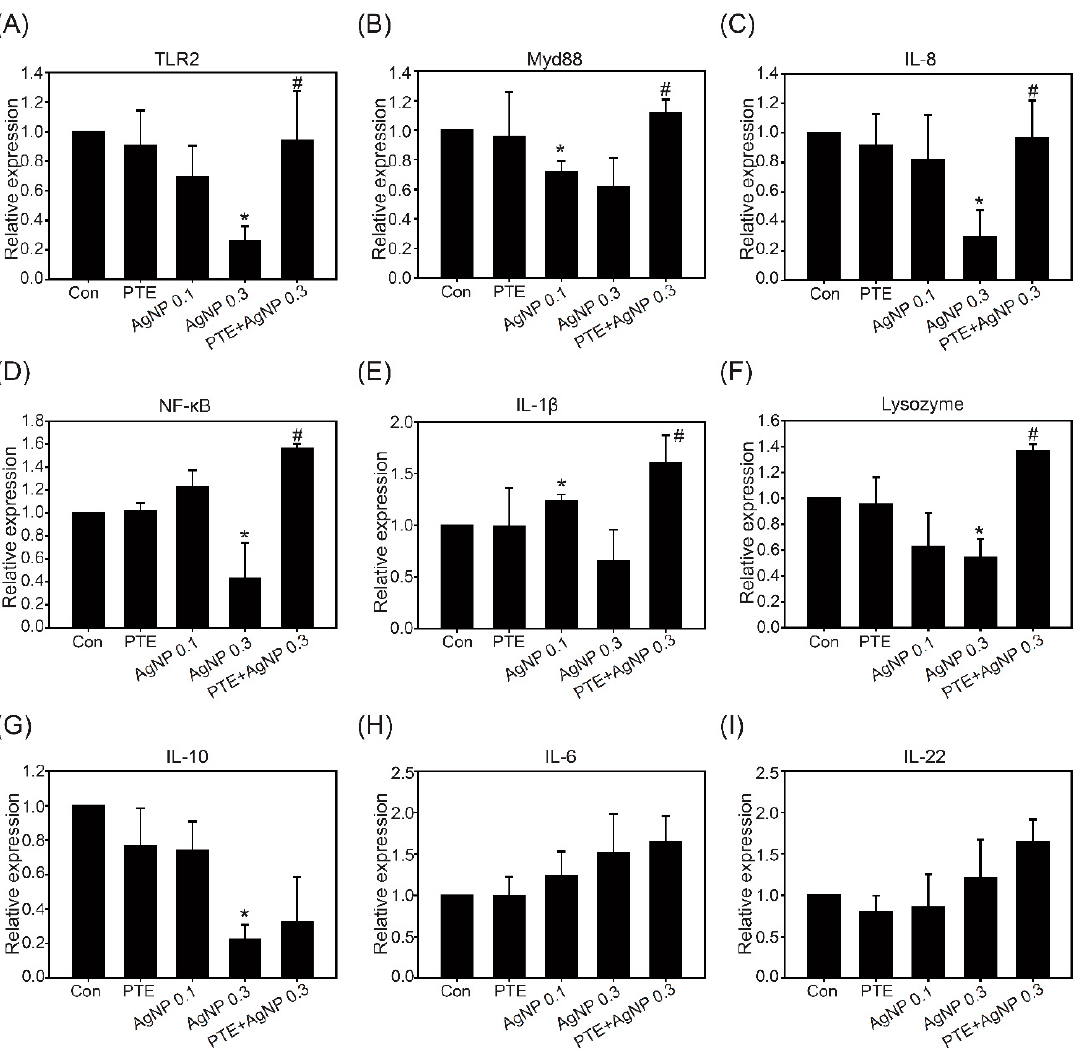
Figure 8. Expression of immune-related genes after 5 dpf exposure. Zebrafish embryos after exposure to control, 0.3 µ g/mL PLGA-PTE, 0.1 µ g/mL AgNPs, 0.3 µ g/mL AgNPs, and PLGA-PTE + AgNPs for 120 hpf. Then, the genes from whole larvae, including: ( A ) Toll-like receptors 2 ( TLR2 ), ( B ) Myd88 , ( C ) IL-8 , ( D ) NF- κ B , ( E ) IL-1 β , ( F ) Lysozyme, ( G ) IL-10 , ( H ) IL-6 , and ( I ) IL-22 , were analyzed. β -actin served as the internal control. The data are presented from at least three independent experiments. * p < 0.05, AgNPs groups versus control groups; # p < 0.05, PLGA-PTE + AgNPs versus AgNPs groups.